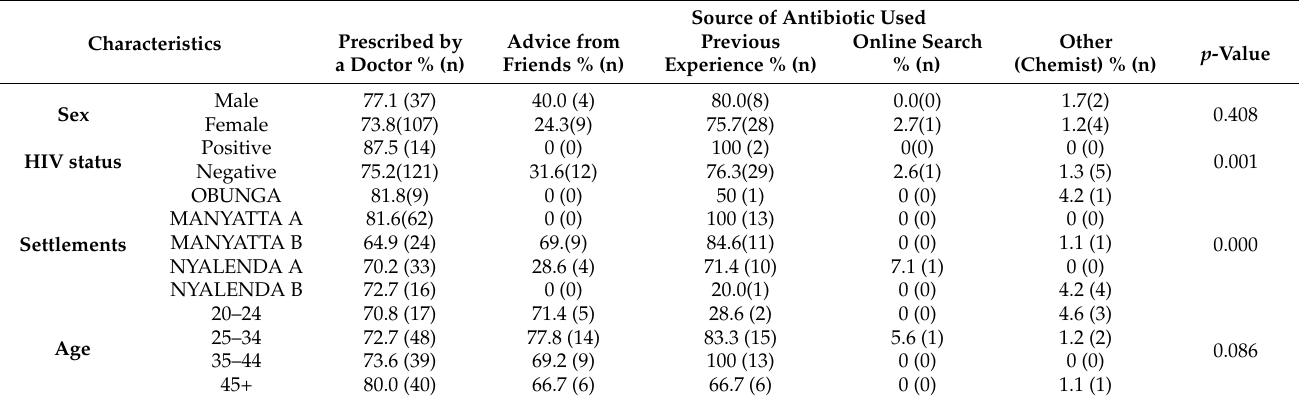
Table 2. Percentage distribution of sources of antibiotics used against demographic and clinical characteristics of the study participants.